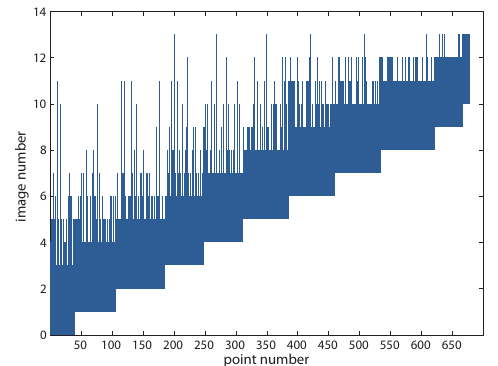
Figure 3: Indices of the images in the sequence in which each object point was